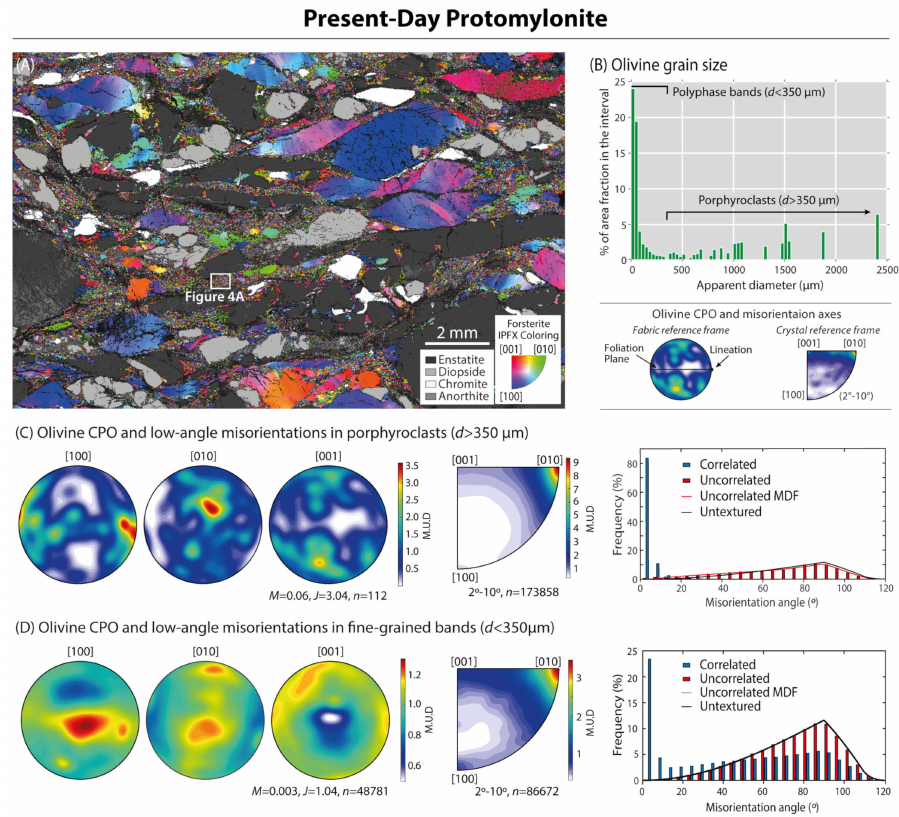
Figure 3. Microstructure results from the present-day protomylonite. ( A ) Combined EBSD phase and inverse pole figure (IPF) map illustrating the microstructure of the protomylonite. The inverse pole figure map of olivine crystallographic axis orientation is colored relative to the lineation, which is parallel to the upper edge of the map (IPF-X coloring). Black lines correspond to grain boundaries. Black areas correspond to zero solutions (not-indexed domains). Step size is 8 µ m. ( B ) Area- weighted distribution of olivine grain size from the map in ( A ). Olivine porphyroclasts tend be larger than 350 µ m, whereas olivine grains in polyphase bands tend to be smaller than 350 µ m (see text for more information). ( C ) Crystallographic preferred orientation (CPO), low-angle misorientation axes distribution, and misorientation angles distribution for olivine porphyroclasts. ( D ) Similar to ( C ) for olivine in the polyphase